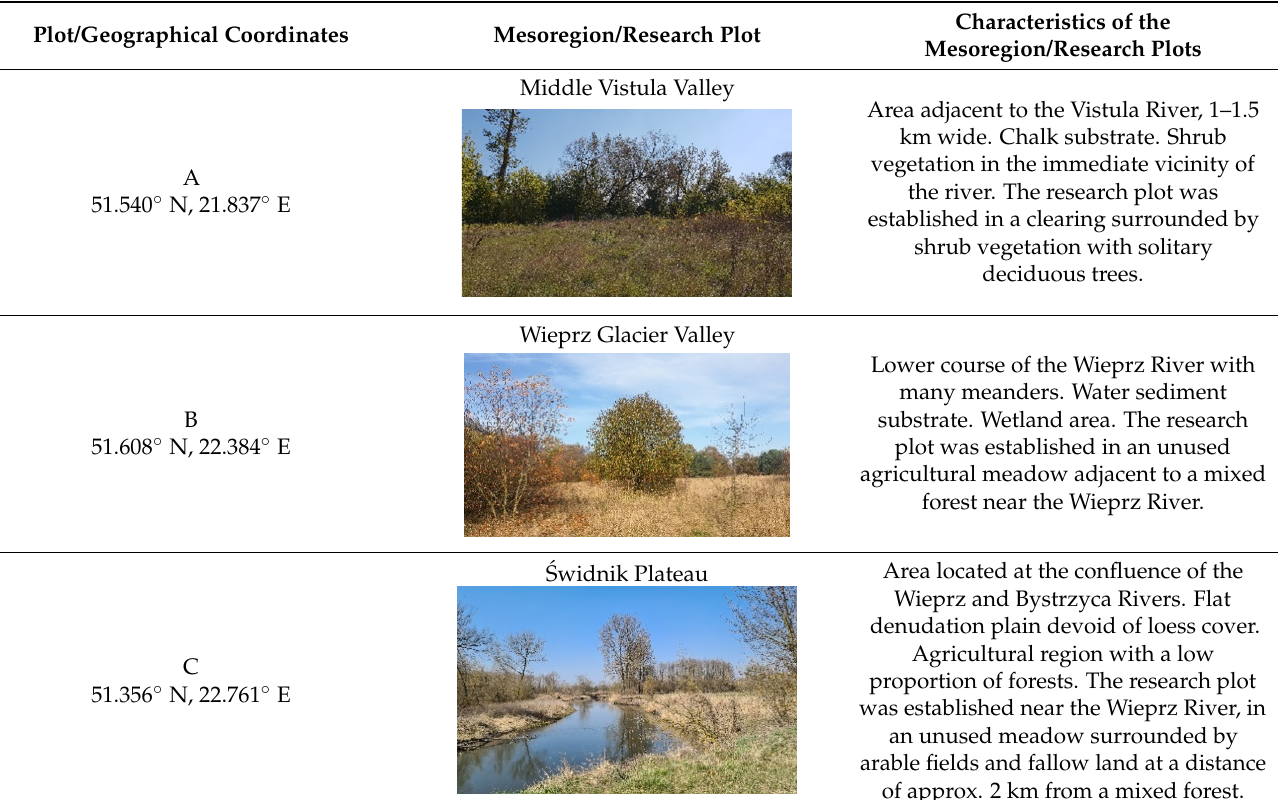
Table 1. General characteristics of the mesoregions and the tick collection sites.